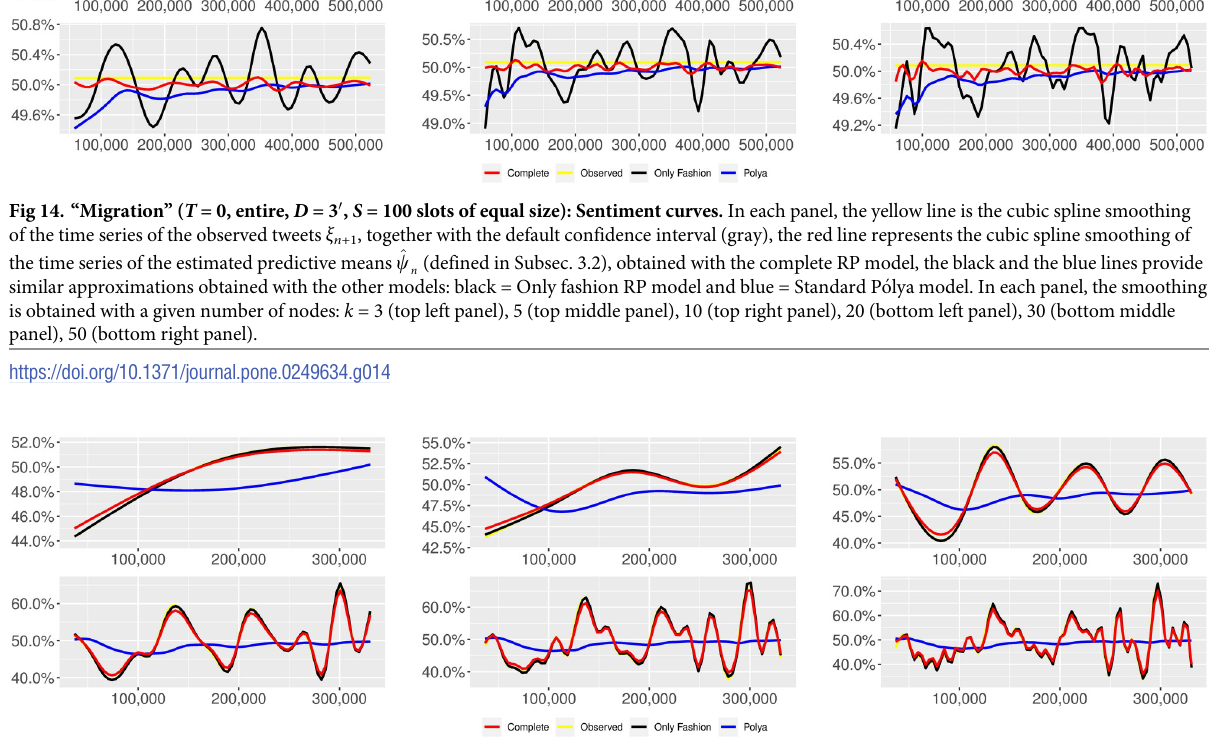
Fig 15. “Migration” ( T = 0.35, entire, D = 3 0 , slots = days): Sentiment curves. In each panel, the yellow line is the cubic spline smoothing of the time series of the observed tweets ξ , together with the default confidence interval (gray), the red line represents the cubic spline smoothing of the time n +1 series of the estimated predictive means ^ c (defined in Subsec. 3.2), obtained with the complete RP model, the black and the blue lines provide similar n approximations obtained with the other models: black = Only fashion RP model and blue = Standard Po´lya model. In each panel, the smoothing is obtained with a given number of nodes: k = 3 (top left panel), 5 (top middle panel), 10 (top right panel), 20 (bottom left panel), 30 (bottom middle panel), 50 (bottom right panel).